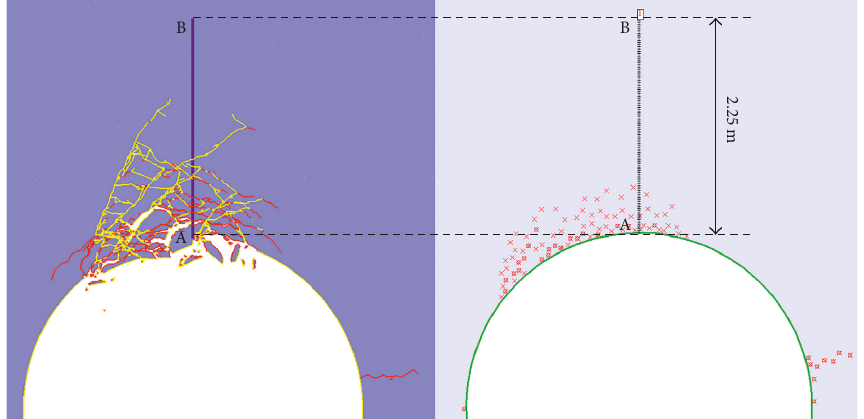
Figure 12: Monitoring line along the Y axis placed at the crown of the tunnel within the intact FDEM (left) and FEM (right) models for monitoring the principal stresses. The symbols (A) and (B) indicate the starting and ending point of the monitoring line, respectively. The obtained stress results are shown in Figures 11 and 13 for the major and minor principal stresses, respectively. (Left) Cohesive elements failing in tension (Mode I fractures) are coloured red, and cohesive elements failing in shear (Mode II fractures) are coloured yellow. (Right) Yielded elements in shear ( ) and in tension ( ) are plotted. × ○